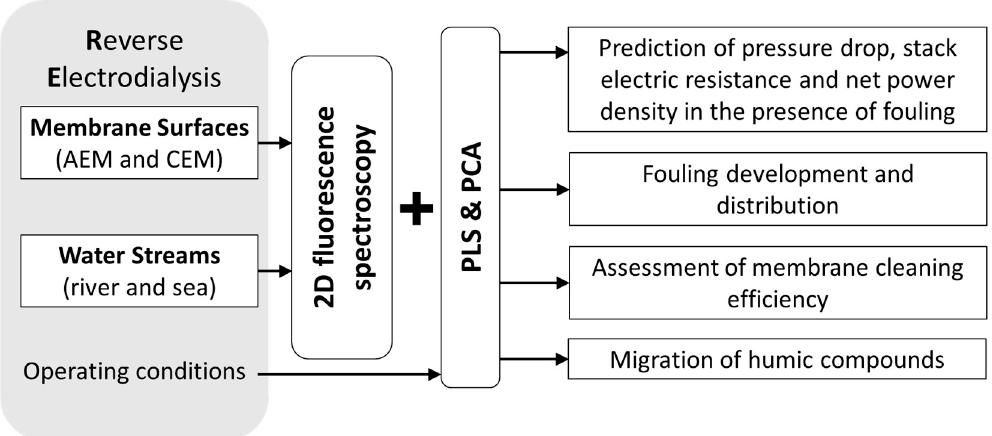
Figure 9. Applicability of 2D fluorescence spectroscopy combined with non-mechanistic modelling (projection to latent structures and principal component analysis) for the monitoring of a reverse electrodialysis (RED) process (AEM—anion exchange membrane; CEM—cation exchange membrane) [22,23].